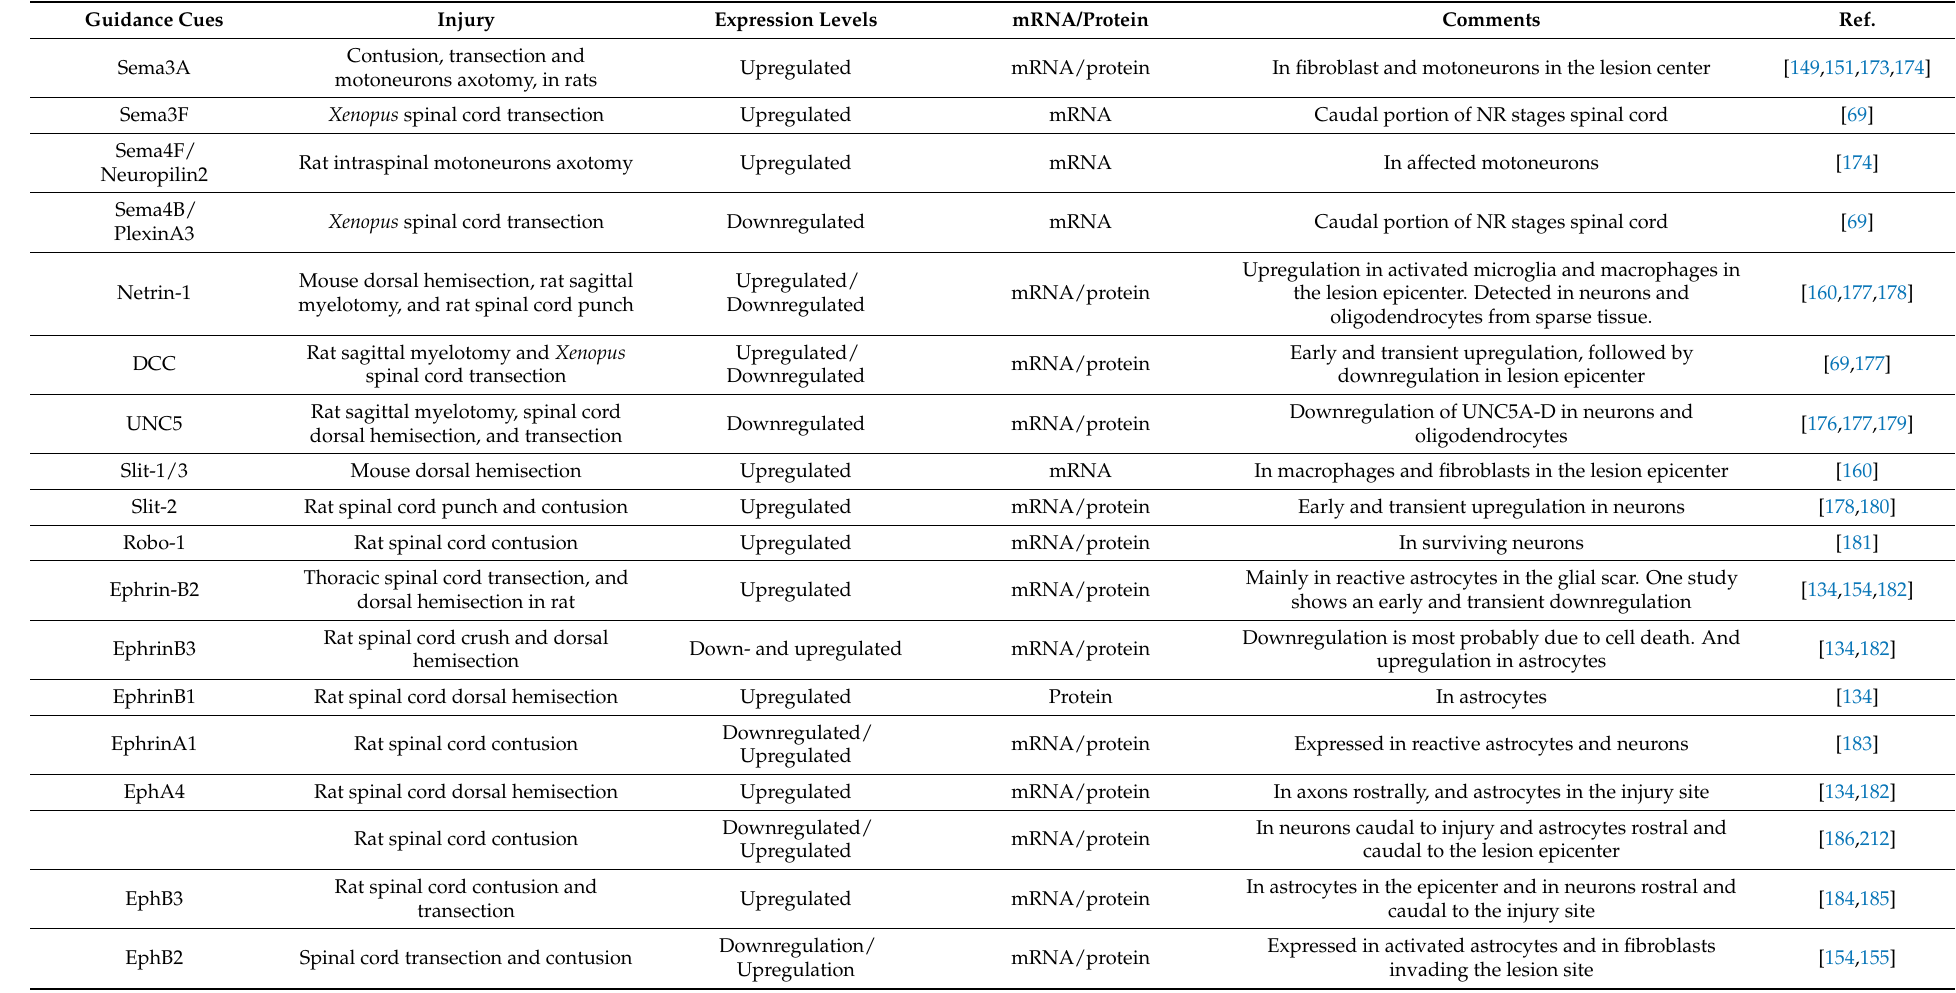
Table 1. Differential expression of guidance cues after different SCI